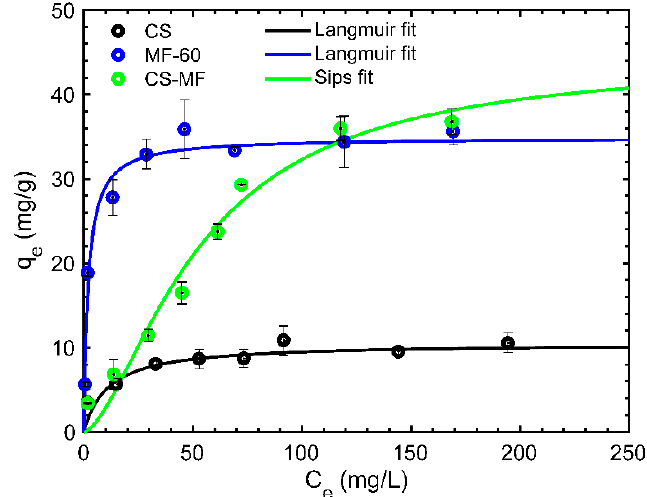
Figure 6. Equilibrium isotherm curves adjusted to Langmuir model (T: 25 °C, SD: 1 g/L; AS: 150 rpm; CT: 24 h; pHi: 4; C i : 5–200 mg/L). Table 2. Langmuir, Freundlich, and Sips constants of CS-MF, MF-60, and